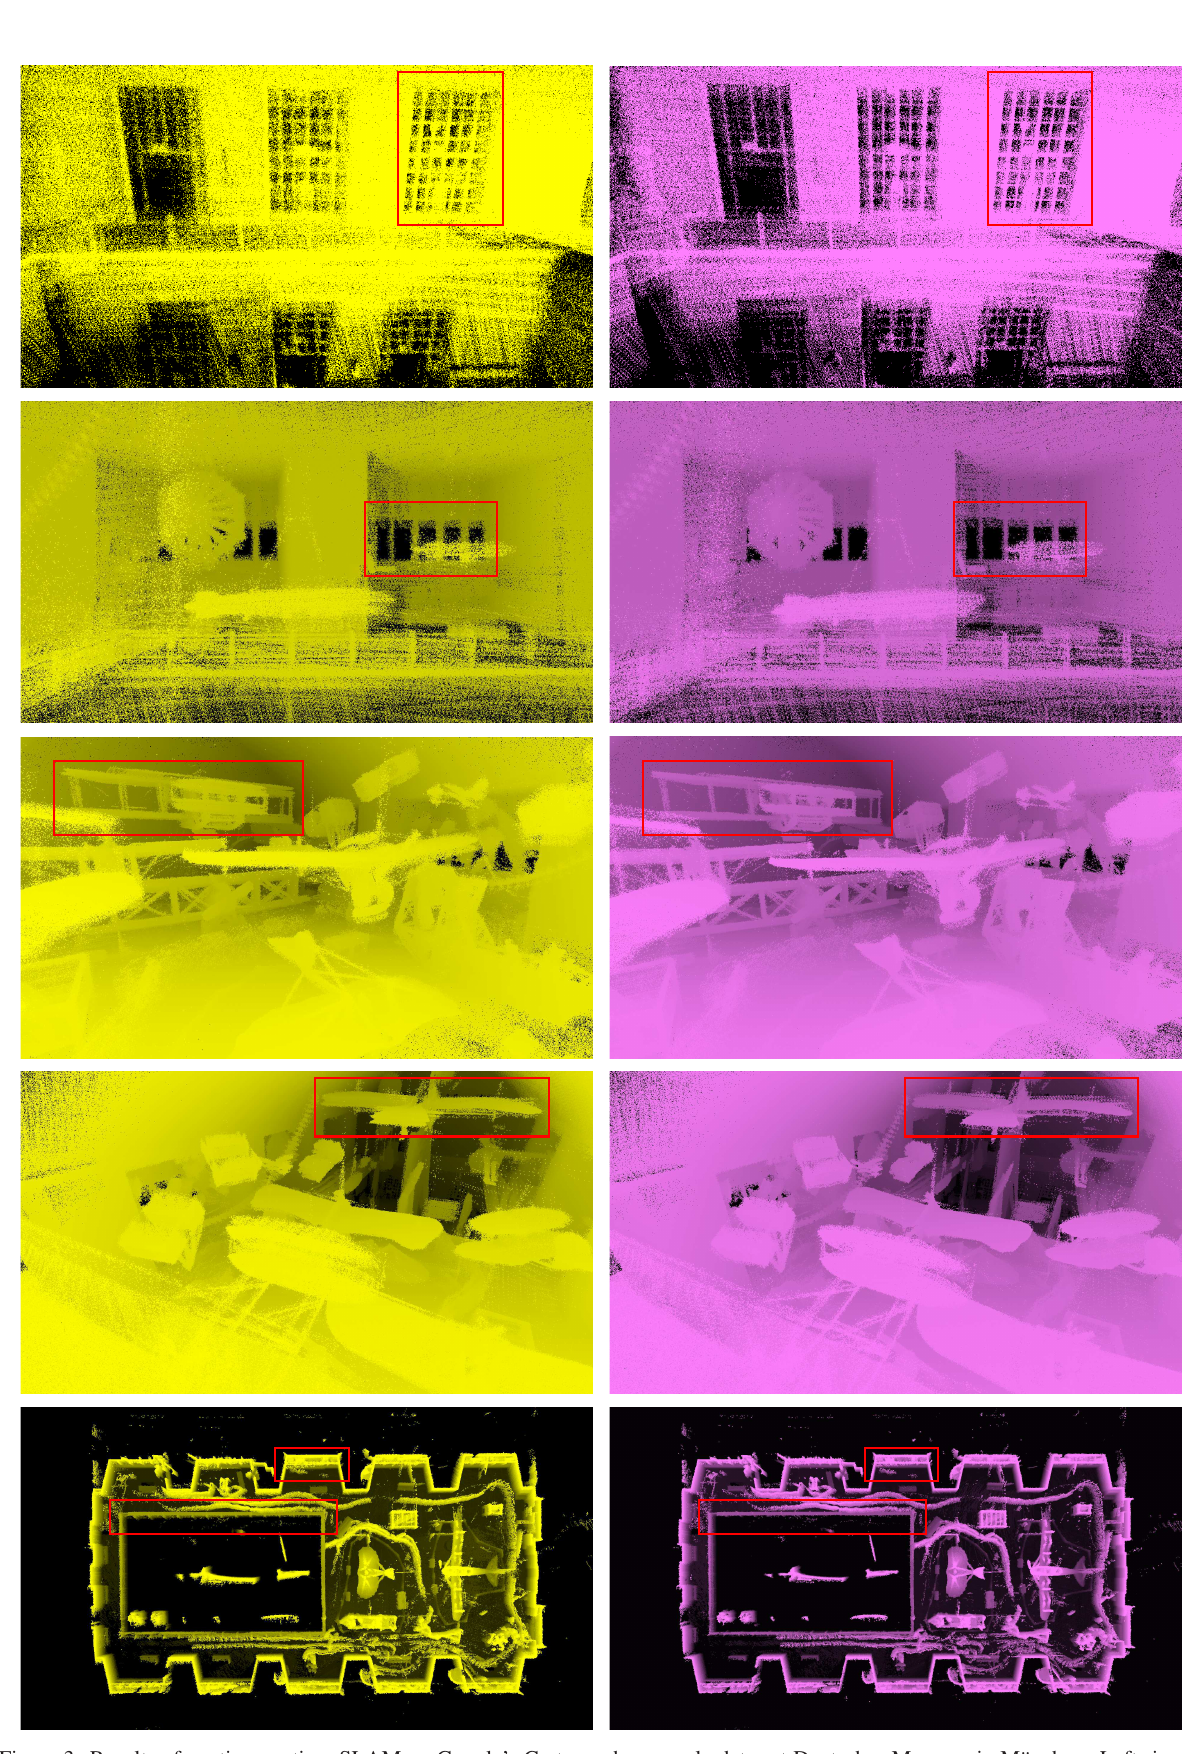
Figure 3: Results of continuous-time SLAM on Google’s Cartographer sample data set Deutsches Museum in M¨unchen. Left: input. Right: output of our solution. Shown are 3D views (perspective) of the scene. Major changes in the point cloud are highlighted in red. Continued in Figure